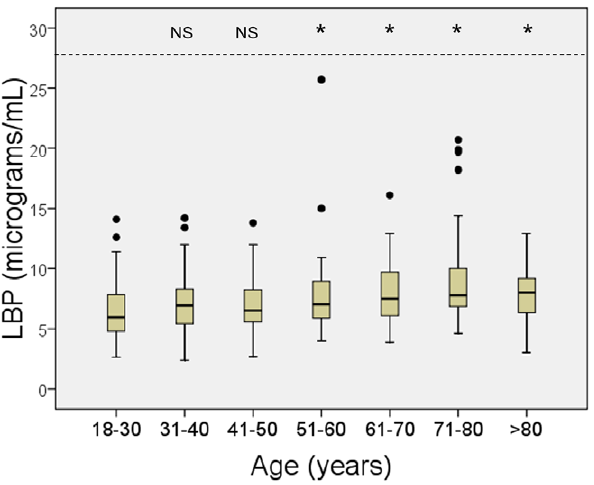
Figure 2. Serum concentrations of lipopolysaccharide-binding protein (LBP) in the different age strata. Horizontal lines represent median values, boxes represent the interquartile range, whiskers represent the range, and dots represent extreme values (higher than the 75 th percentile plus 1.5 times the interquartile range). The P-values (top of the figure) reflect comparisons to the group of 18–30 year-old (Mann-Whitney test). NS, not significant (P . 0.05); *, P , 0.005.